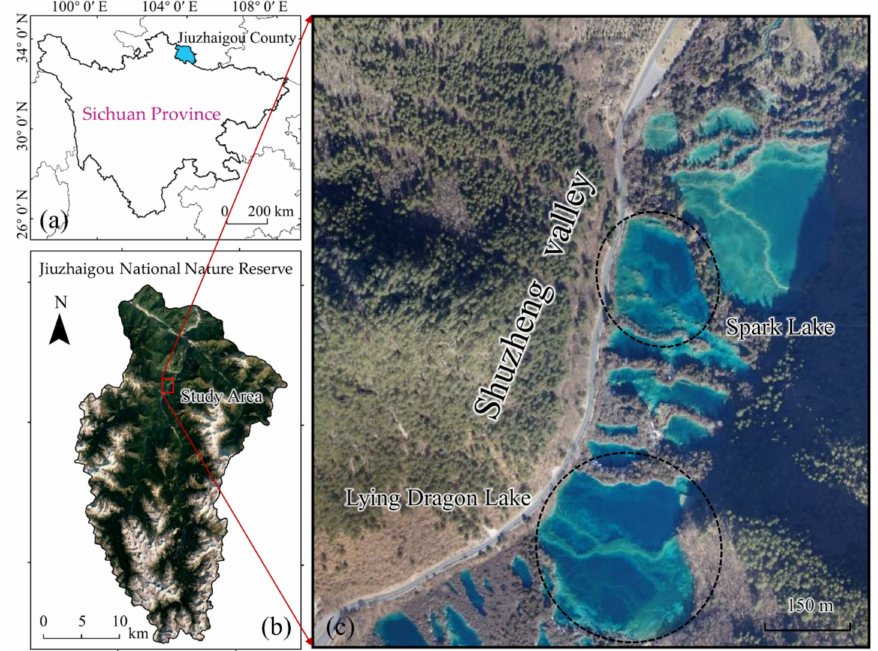
Figure 2. Location of the study area. ( a ) Jiuzhai County in Sichuan Province, ( b ) Jiuzhaigou National Nature Reserve, and ( c ) the main tufa lakes in Shuzheng